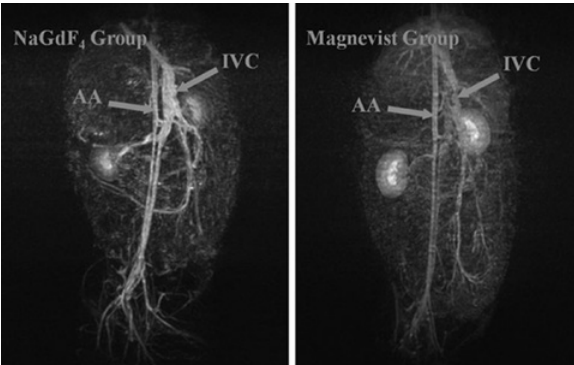
Figure 17: MR angiography of rabbits within 3 min after injecting with the NaGdF nanodots (left) or Magnevist (right) at the same 4 dosage (13 mg Gd/kg): abdominal aorta (AA) and inferior vena cava (IVC). Taken from [303]. Reproduced with permission of John Wiley and Sons. Copyright © 2014.